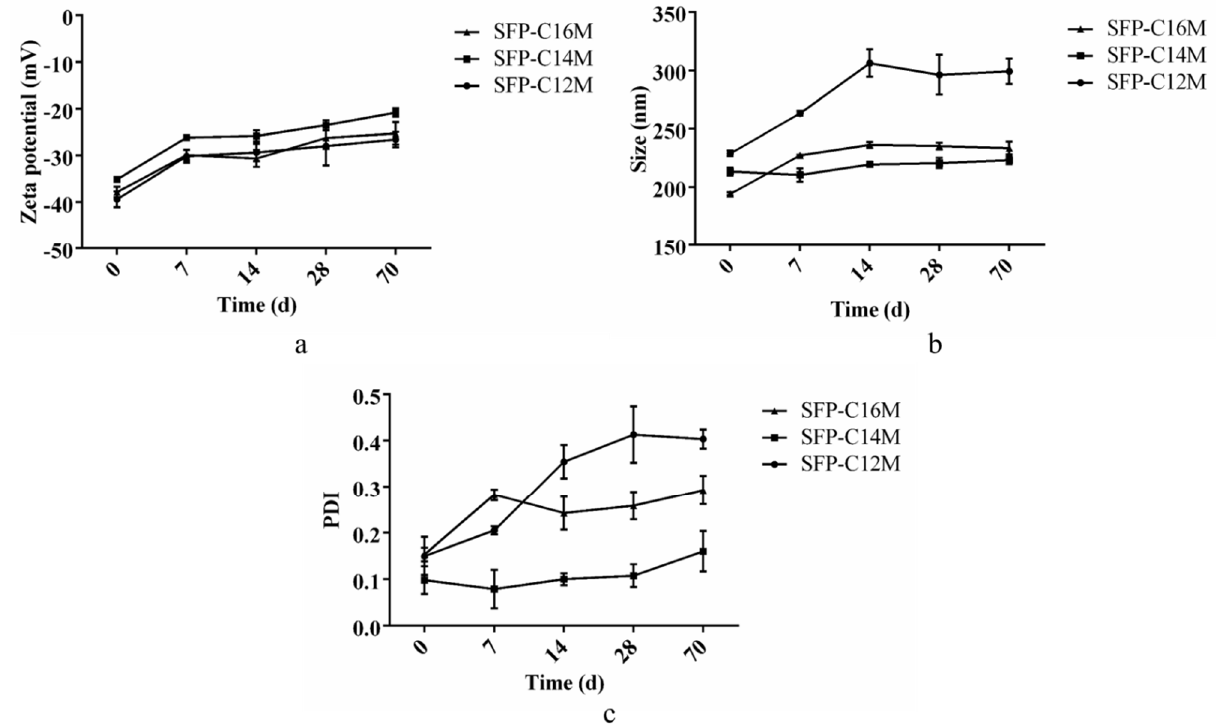
Figure 5. Determination of micelle stability. The results are the means ± SD ( n = 3). ( a ) Changes in the zeta potential; ( b ) changes in the particle size; ( c ) changes in the PDI.